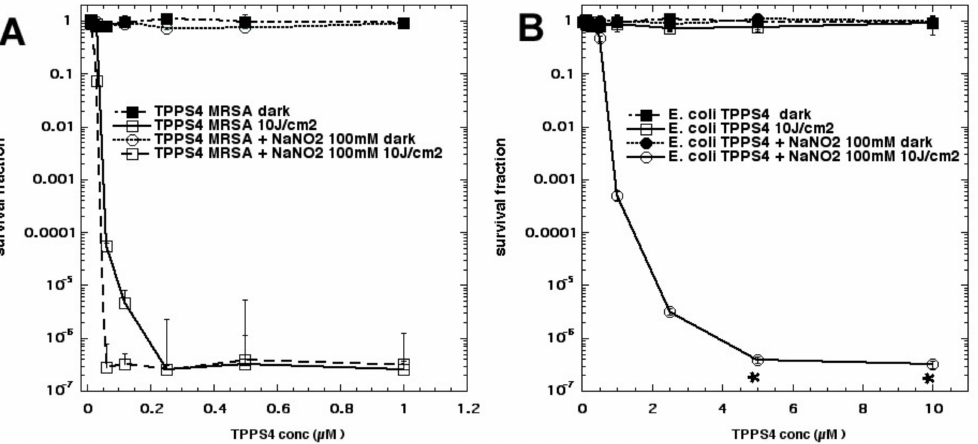
Figure 16. aPDI is potentiated by sodium nitrite. ( A ) MRSA; ( B ) E. coli . Unpublished data submitted for